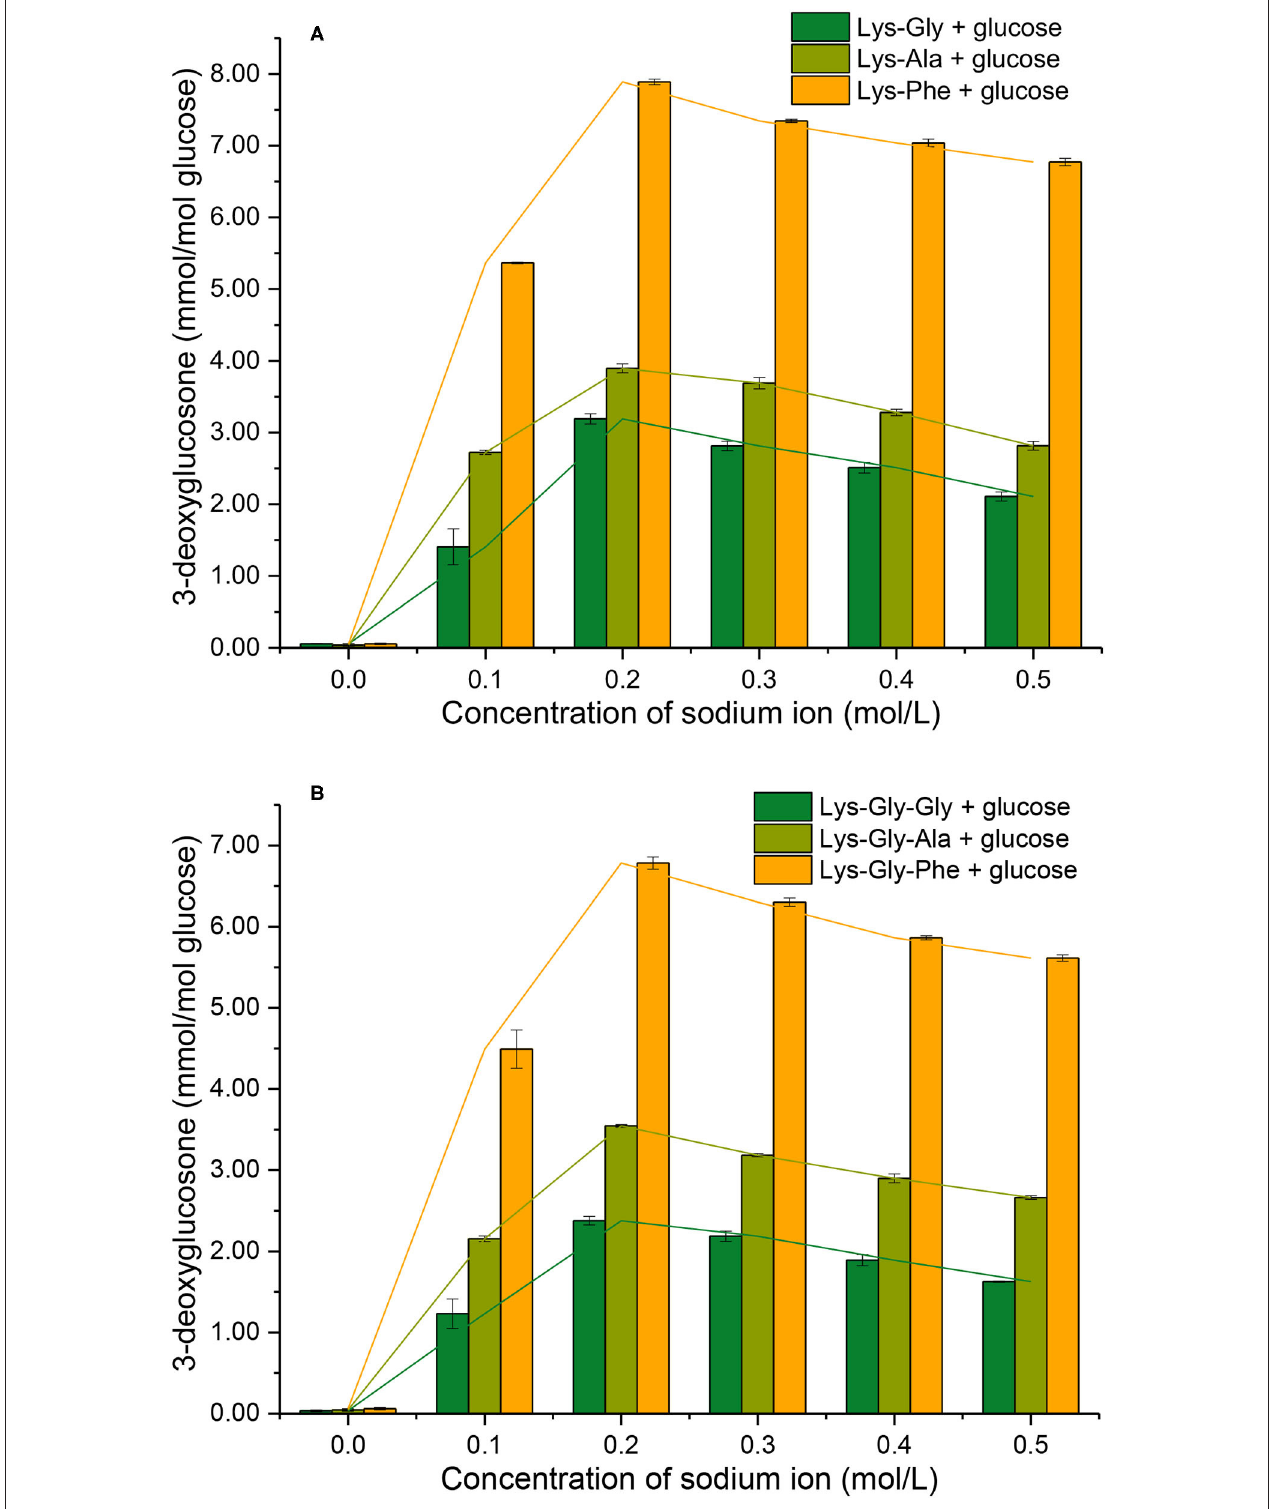
FIGURE 6 | 3-deoxyglucosone formation from the Maillard reaction of peptides with glucose at different sodium ion concentrations [ (A) : in the mixtures containing dipeptides; (B) : in the mixtures containing tripeptides].